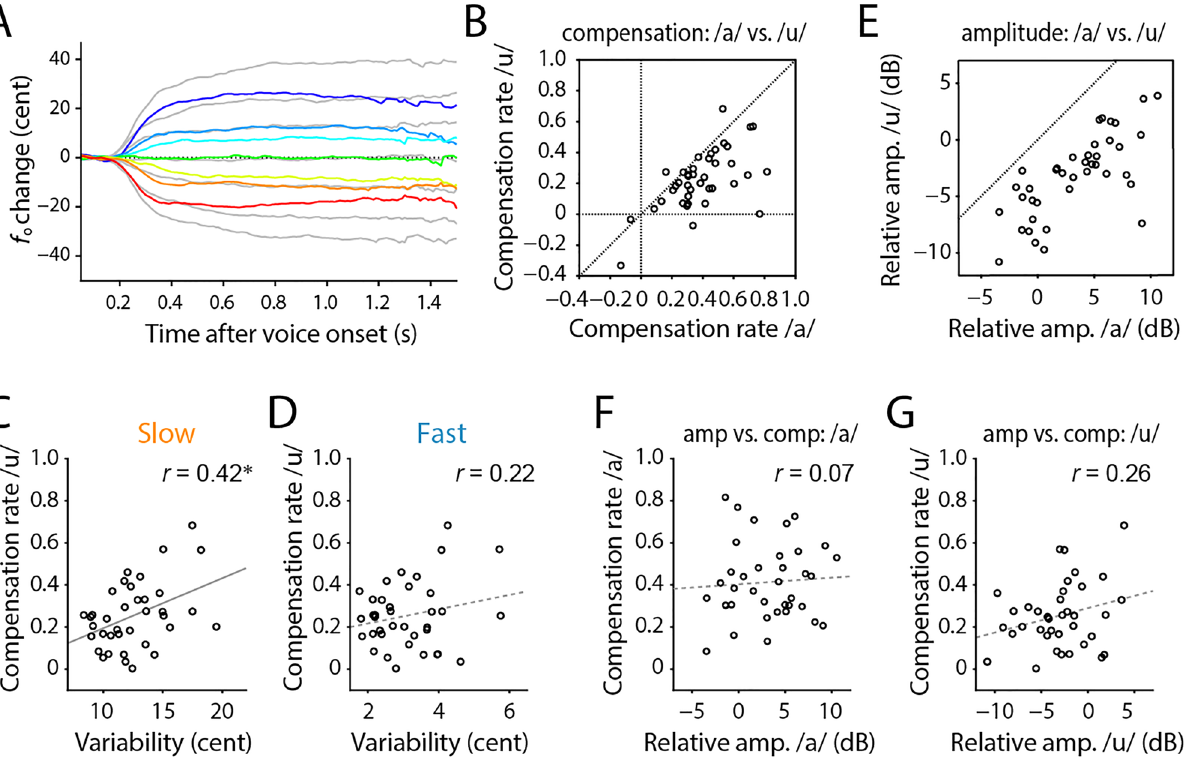
Figure 6. Vowel differences in compensation ratio, amplitude, and variability. ( A ) Vocal responses against f o shifts in auditory feedback for /u/ vocalization (colored lines), those for /a/ trials as comparisons (gray lines). ( B ) The compensation ratio for /u/ vocalizations was generally smaller than that for /a/. ( C , D ) Correlation between the compensation ratio and variability of slow ( C ) or fast ( D ) components, respectively, for the /u/ vocalizations. ( E ) The voice amplitude of /u/ vowel was generally lower than that of /a/. ( F , G ) Voice amplitudes of /a/ ( F ) and /u/ ( G ) vowels did not show significant correlations with the compensation ratio. Asterisk (*) indicates significant correlation ( p <